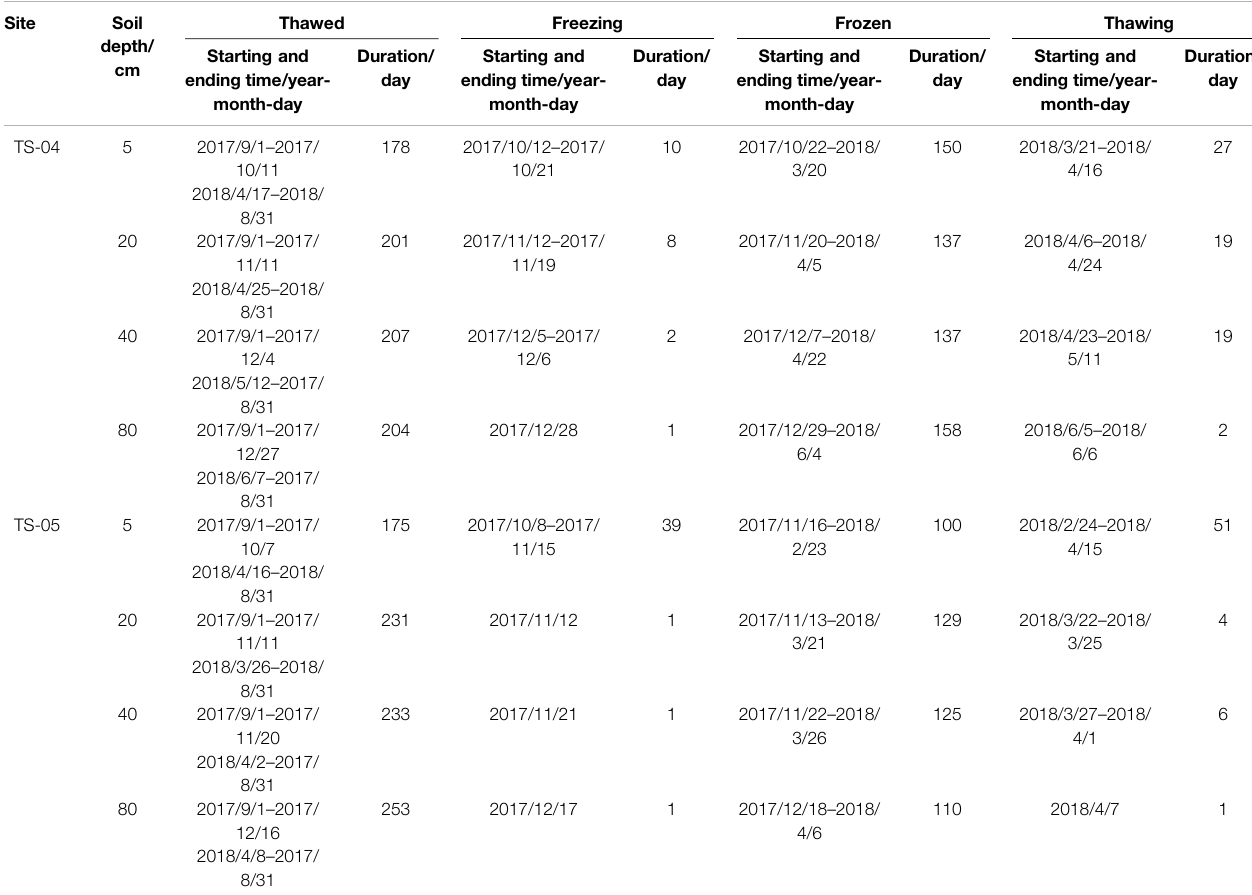
TABLE 2 | The time of soil freeze-thaw process at different